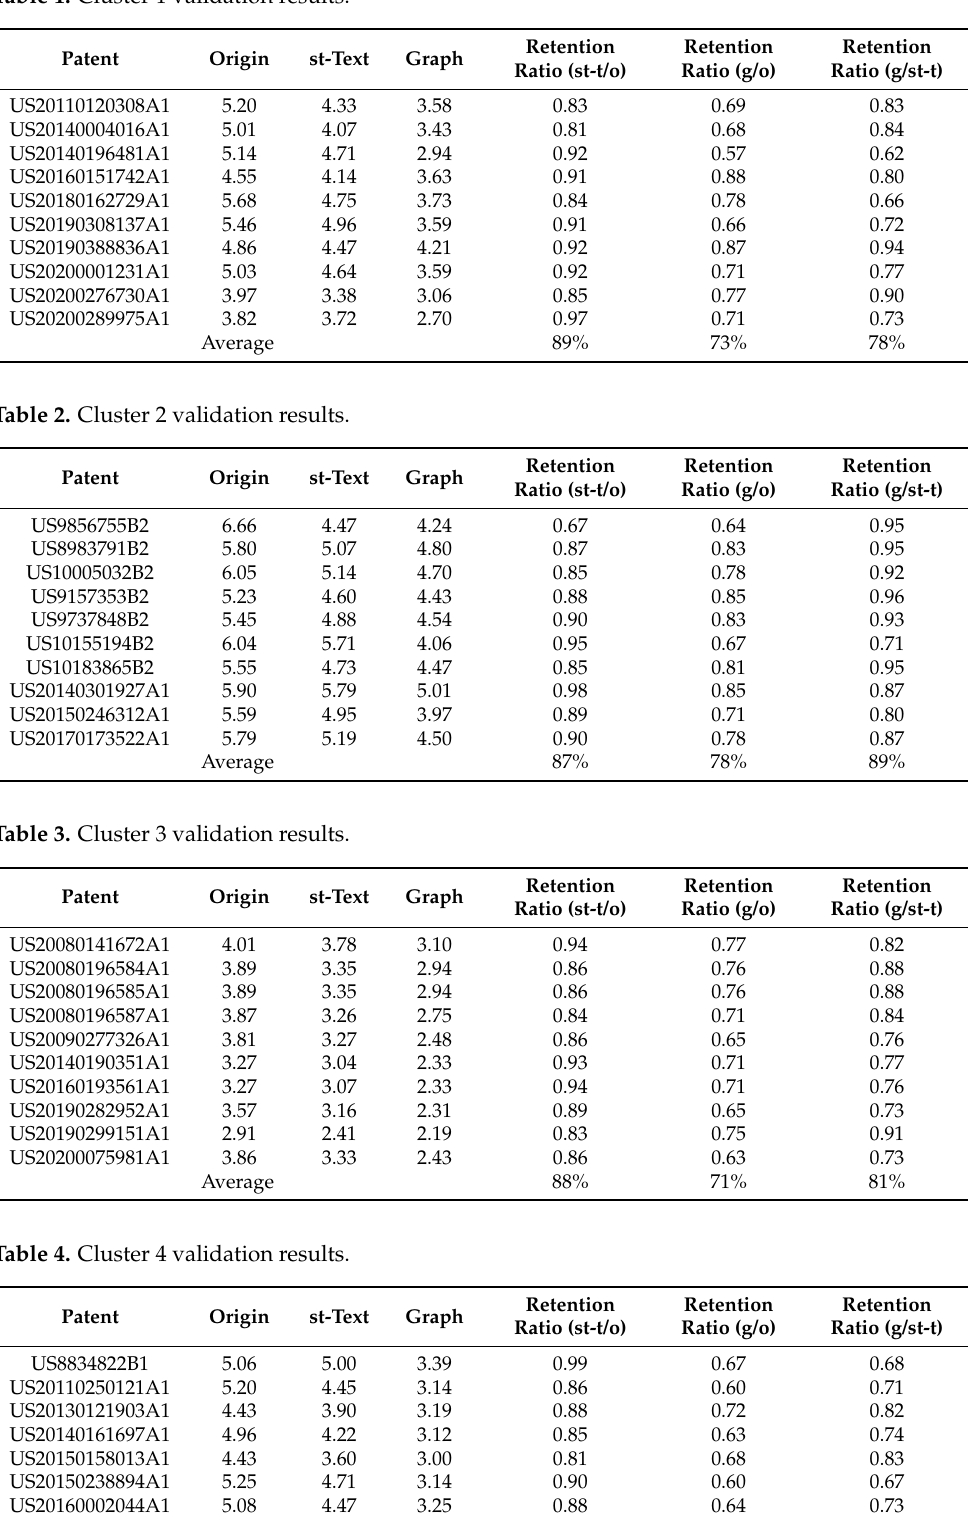
Table 1. Cluster 1 validation results.